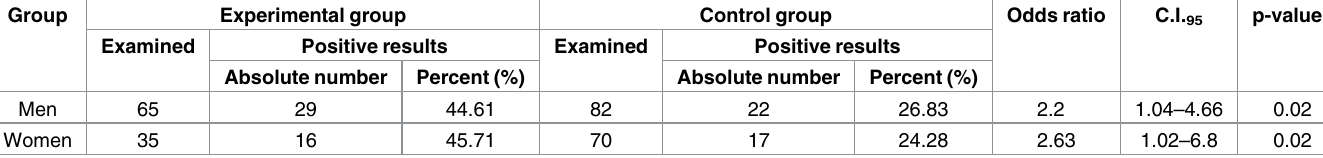
Table 3. Comparative gender prevalenceof chronic toxoplasmosis in the experimental group and the control group.